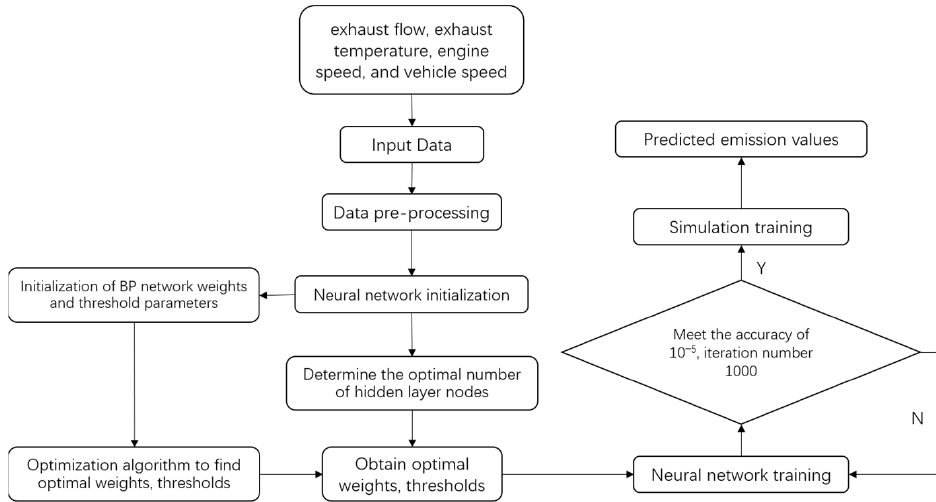
Figure 7. Flow chart of GA-BP NN